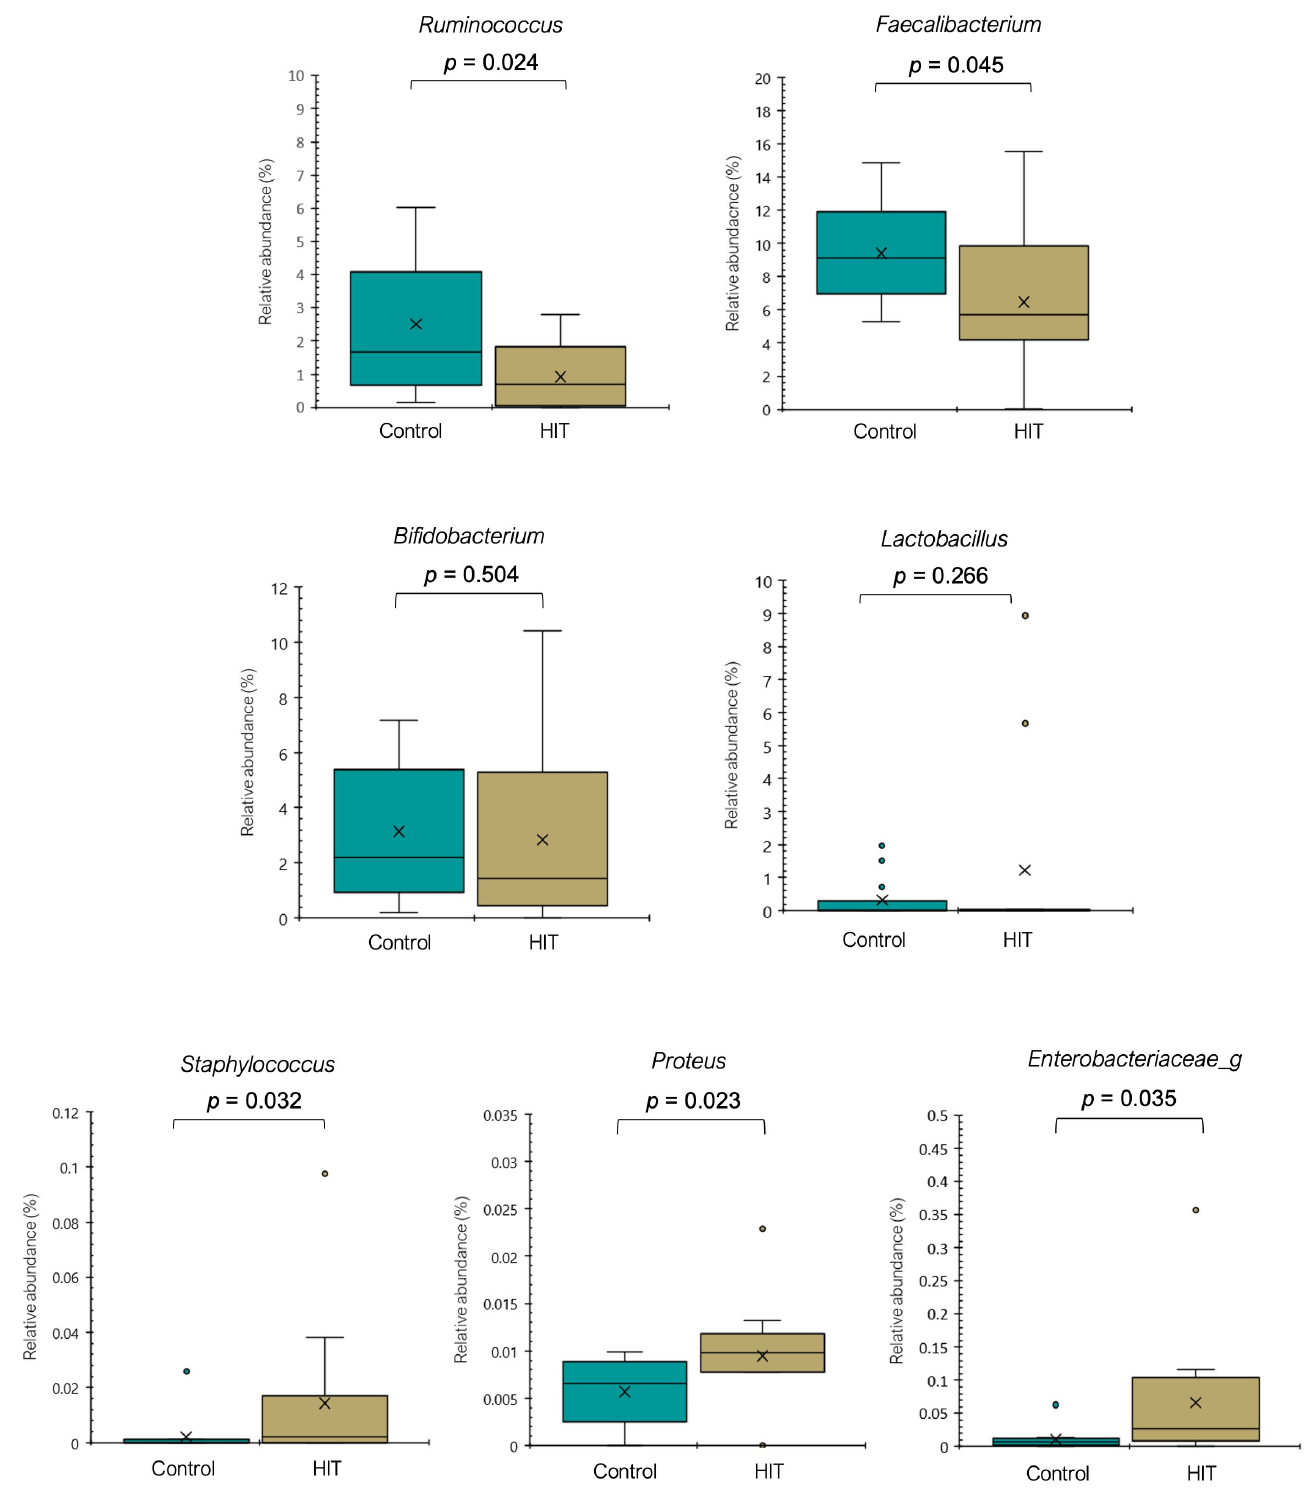
Figure 2. Relative abundance (%) of different genera in the control and HIT groups. Mean values are represented with an × and values statistically considered as outliers (atypical values) are plotted as